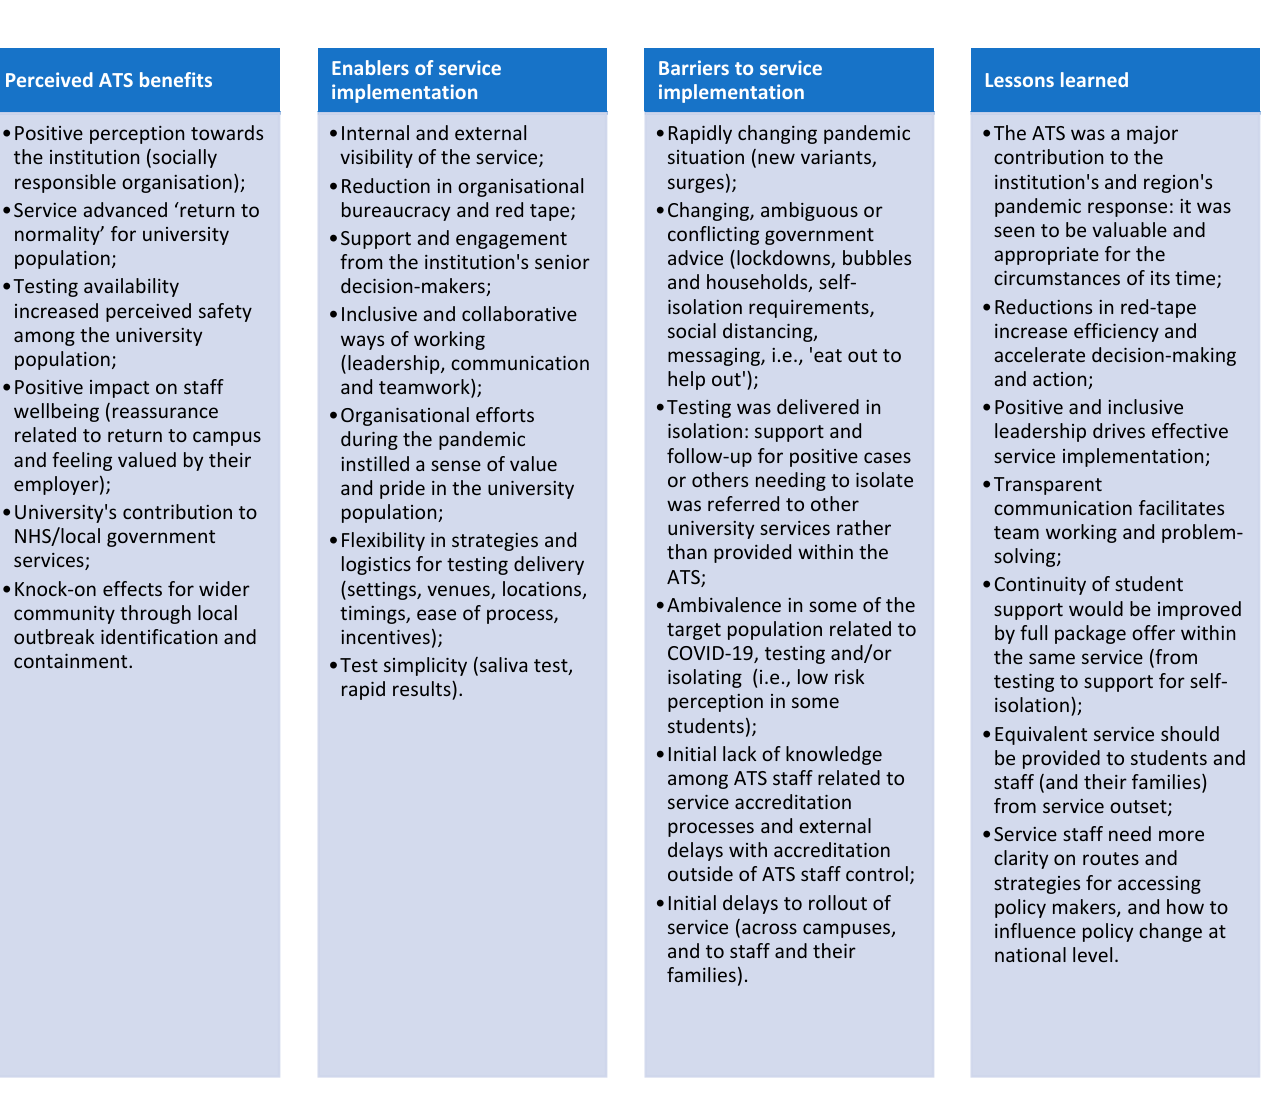
Figure 4. Perceived benefits, key enablers and barriers to service implementation, and lessons